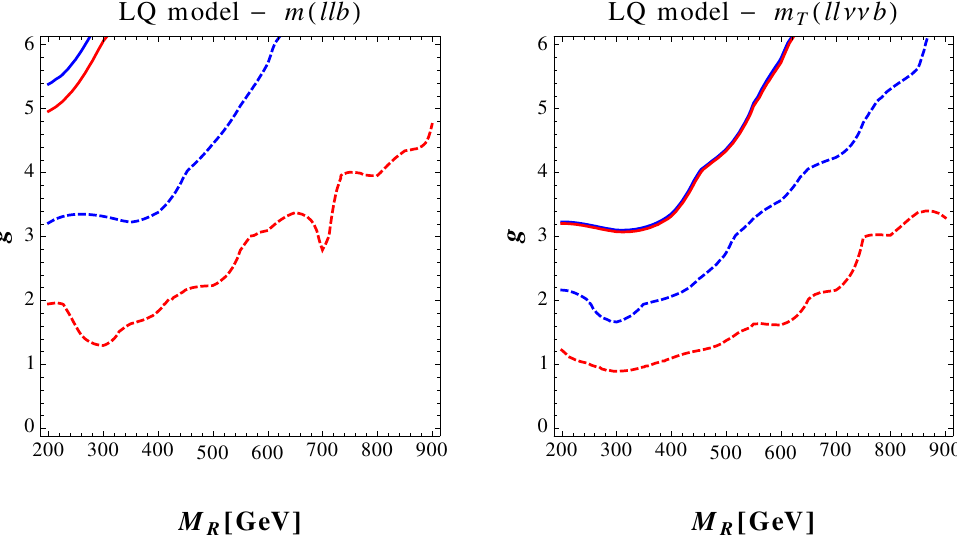
Figure 8 . 95% CL expected exclusion regions in the M R vs g plane: the left plot makes use of the m ( llb ) distribution while the right plot makes use of the m T ( ll(cid:23)(cid:23)b ) distribution. The solid (dashed) blue curves correspond to the pessimistic (optimistic) scenario at 300 fb (cid:0) 1 while the solid (dashed) red curves correspond to the pessimistic (optimistic) scenario at 3000 fb (cid:0) 1 .